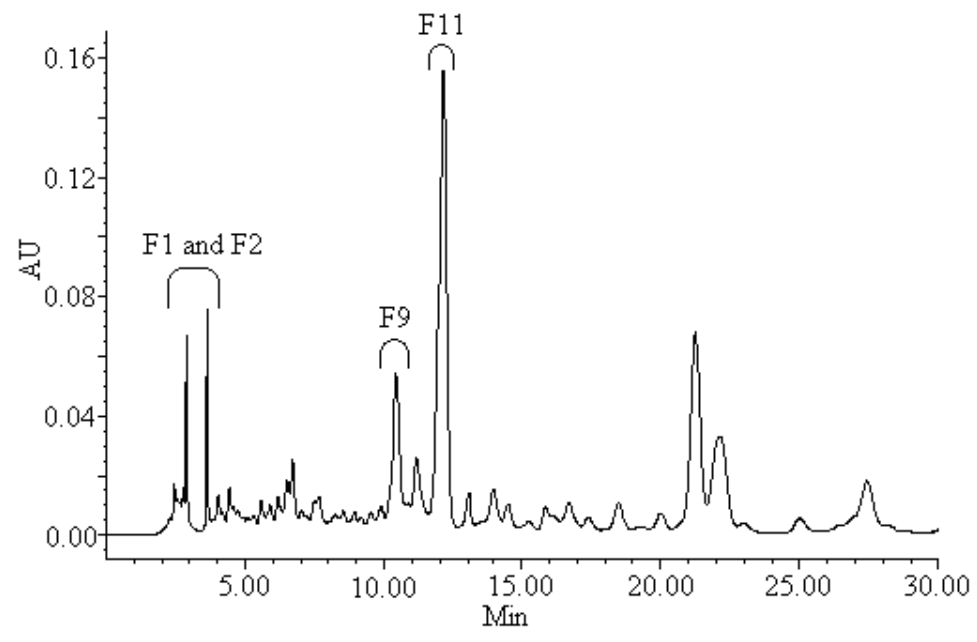
Figure 4. HPLC chromatogram (330 nm) of the aqueous methanolic extract of B. textilis McClure with indication of the active antiradical fractions. Fractions (F1, F2, F9 and F11) of the extract presented antioxidant activity.